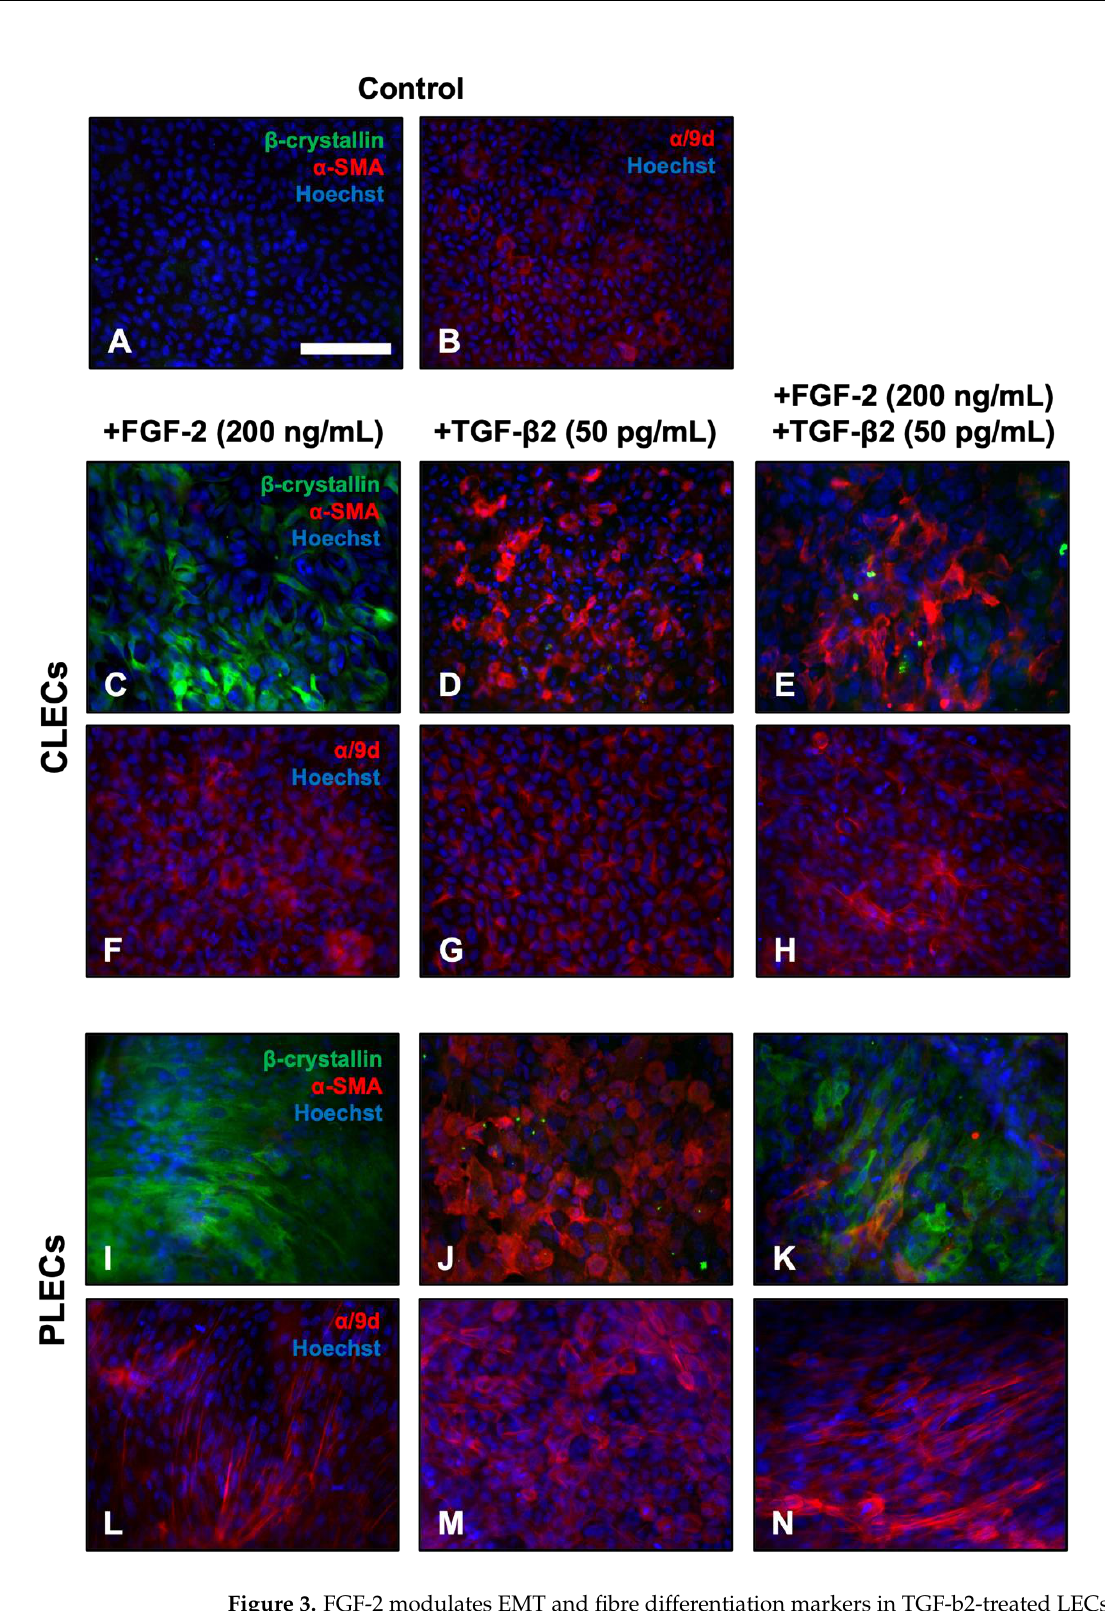
Figure 3. FGF-2 modulates EMT and fibre differentiation markers in TGF-b2-treated LECs. Immunolabeling of β -crystallin (green), α -SMA (red), and alpha-tropomyosin ( α /9d; red), counterstained with Hoechst nuclear stain (blue), in CLECs ( C – H ) and PLECs ( I – N ) following 3 days of culture with no growth factors (Control, A , B ), FGF-2 (200 ng/mL; C , F , I , L ), and TGF- β2 (50 pg/mL; D , G , J , M ), or cotreated with FGF-2 and TGF- β2 ( E , H , K , N ). Images are representative of three independent experiments. Scale bar: 100 μ m.